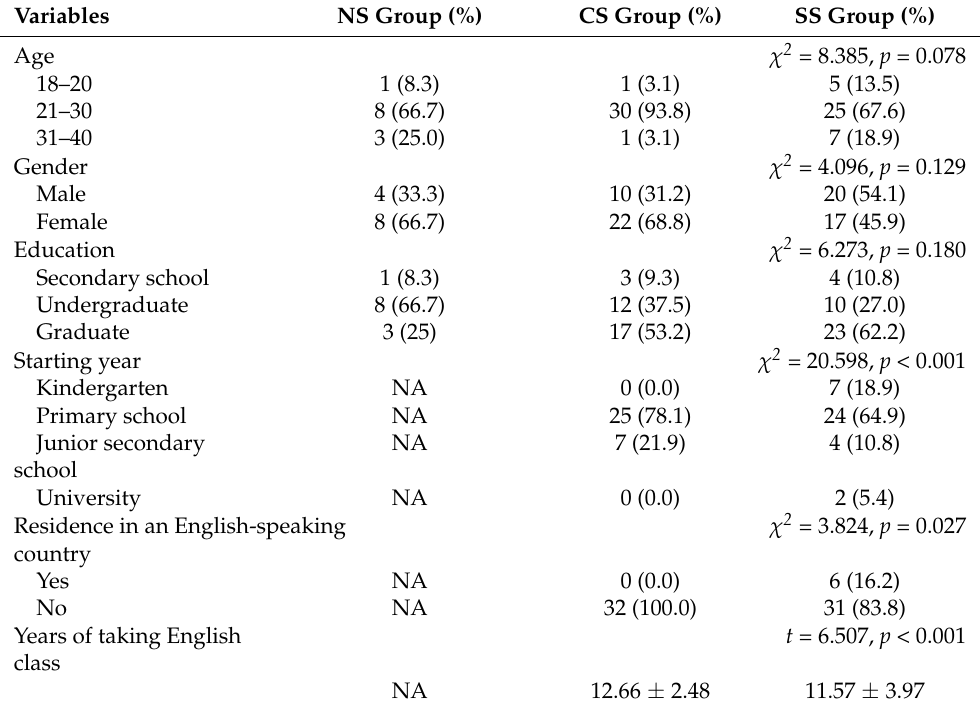
Table 1. Demographic information for all